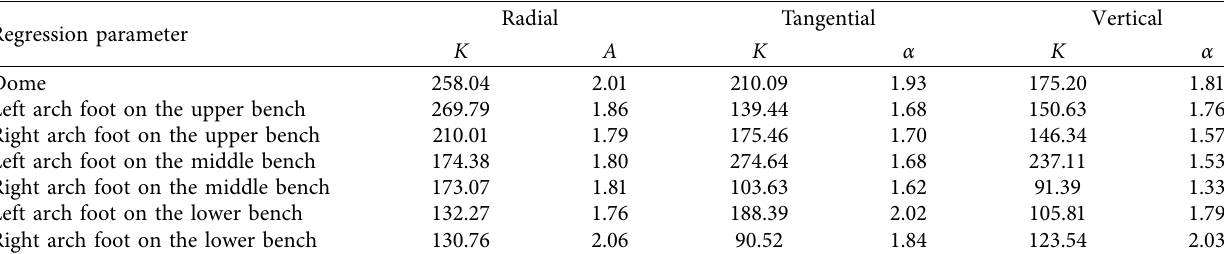
Table 1: Parameter value of vibration velocity regression equation at different positions of the tunnel. Radial Tangential Vertical Regression parameter